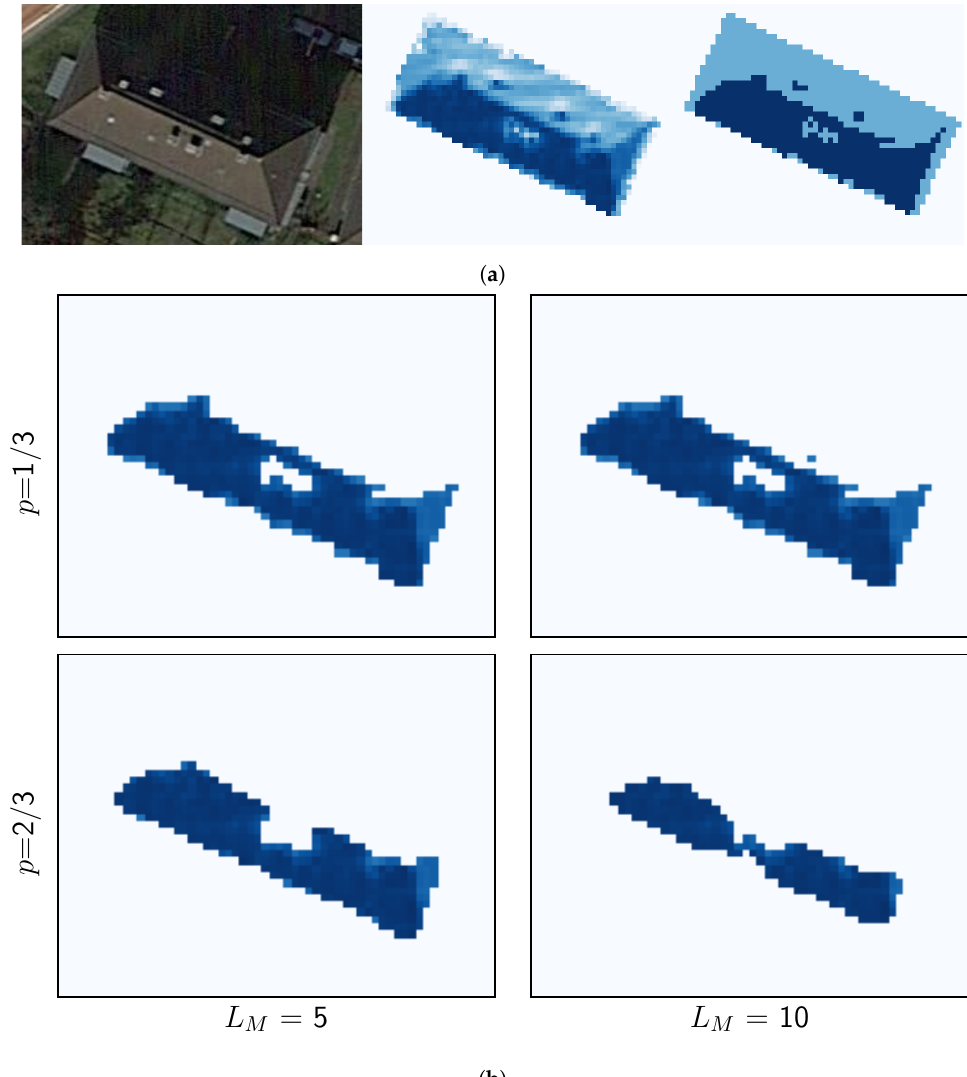
Figure 5. Neighbourhood-based filtering on a single rooftop. The area displayed is 25 m × 25 m with each raster cell having an edge length of 0.5 m. ( a ) Example rooftop represented (from left to right) as satellite imagery (Imagery © 2022 AeroWest, GeoBasis-DE/BKG, GeoContent, Maxar Technologies, Map Data © 2022 GeoBasis-DE/BKG (© 2009), raw irradiation data and binary. Binary means that irradiation values above the irradiation cut-off are set to 1 (dark blue) and all other cell values are set to zero (light blue). ( b ) Result of various combinations of M OORE neighbourhood field sizes and values applied to the unity part of the binary image. Larger neighbourhood sizes L M and larger threshold values p are likely to lead to excessive filtering of suitable rooftop